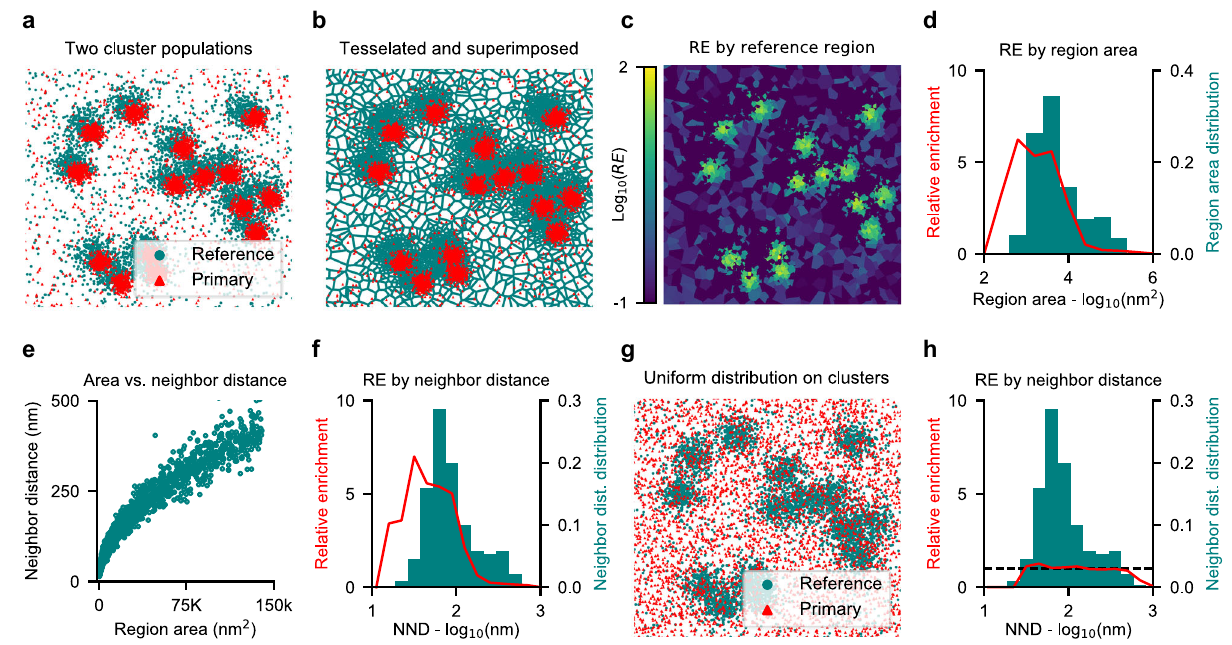
Fig. 2 | Visualising RE across densities for larger images. a Simulation of two colocalizingpopulationsofnormallydistributedclusterswithrandombackground noise.Onespeciesofclustersisslightlyoffsetfromtheother. b Voronoï-regionsof the reference species from ( a ), with the primary species as overlay. c Voronoï regions for the reference species, color-coded by their individual RE scores, cal- culated based on the distribution of the primary species. d Mean RE score across reference densities. Reference regions are binned by area, and mean RE score